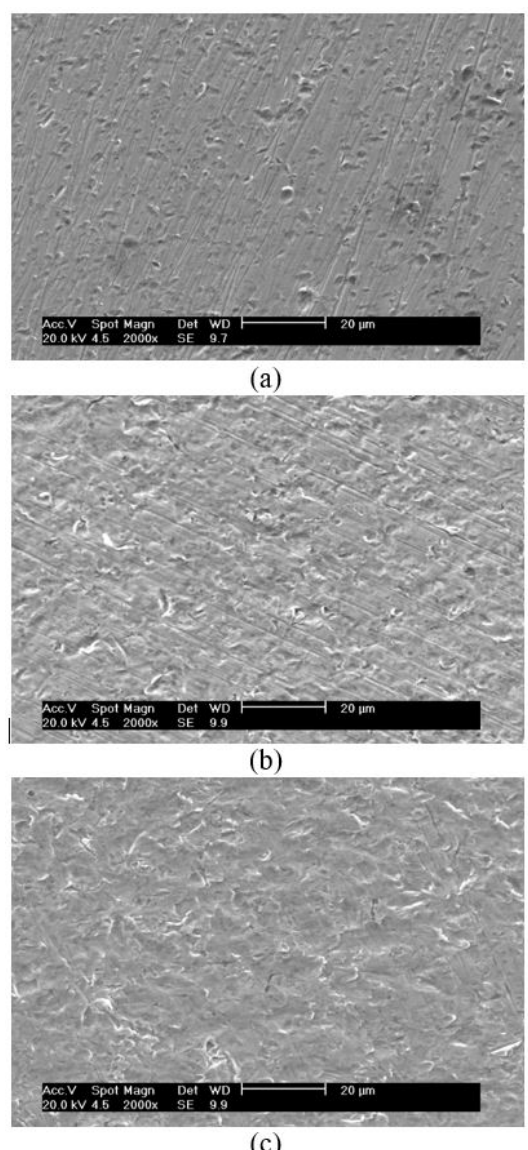
Figure 9. Surfaces of the samples tested with different grain sizes. (a) fine sand (50-75 AFS), (b) medium sand (40-50 AFS) and (c) coarse sand (35-40